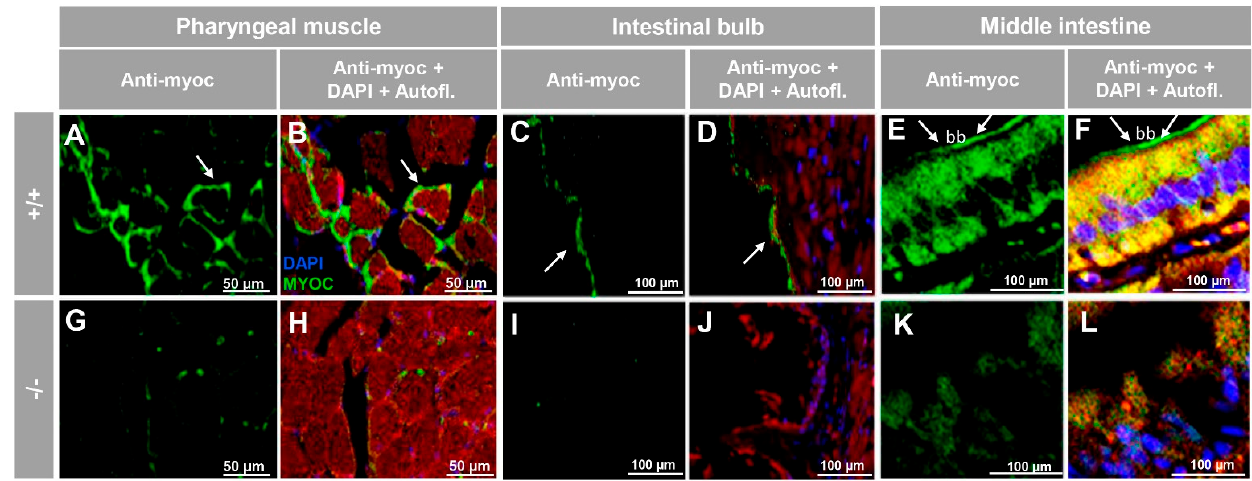
Figure 5. Immunohistochemistry of myocilin in ocular structures of adult zebrafish. Fluorescent immunohistochemistry of iridocorneal dorsal angle ( A , E ), cornea ( B , F ) and retina ( C , D , G ) sections (14 µ m) of wild-type and KO myoc adult zebrafish (7 months). Samples were incubated with an anti-myocilin primary antibody (TNT), followed by Cy2-conjugate goat anti-chicken IgY secondary antibody (green signals). The TNT antibody recognises the N-terminal part of myocilin protein. Expression is seen in the non-pigmented epithelium of the ciliary body and in the iris stroma and iris vessels ( A ), in the corneal endothelium ( B ), and in the ganglion cell layer in the retina ( C , D ) (arrowhead) in wild-type. Red signals correspond to tissue autofluorescence and blue signals correspond to DAPI nuclear staining. al: annular ligament. npe: non-pigmented ciliary epithelium; ibv: iris blood vessels; is: iris stroma. cep: corneal epithelium; cs: corneal stroma; ce: corneal endothelium glc: ganglion cell layer; ipl: inner plexiform layer; inl; inner nuclear layer; opl: outer plexiform layer; onl: outer nuclear layer; phl: photoreceptor layer. re: retina+/+: wild-type; − / − : myoc KO. The negative controls are shown in Figure S4.